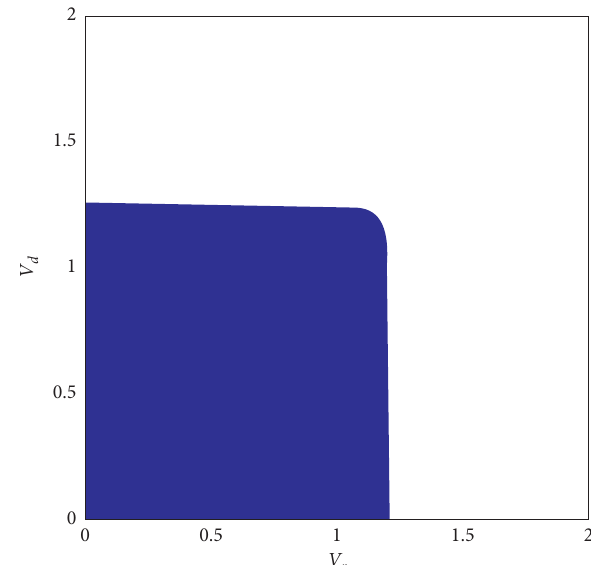
Figure 1: Local stable region of the equilibrium point E ∗ .